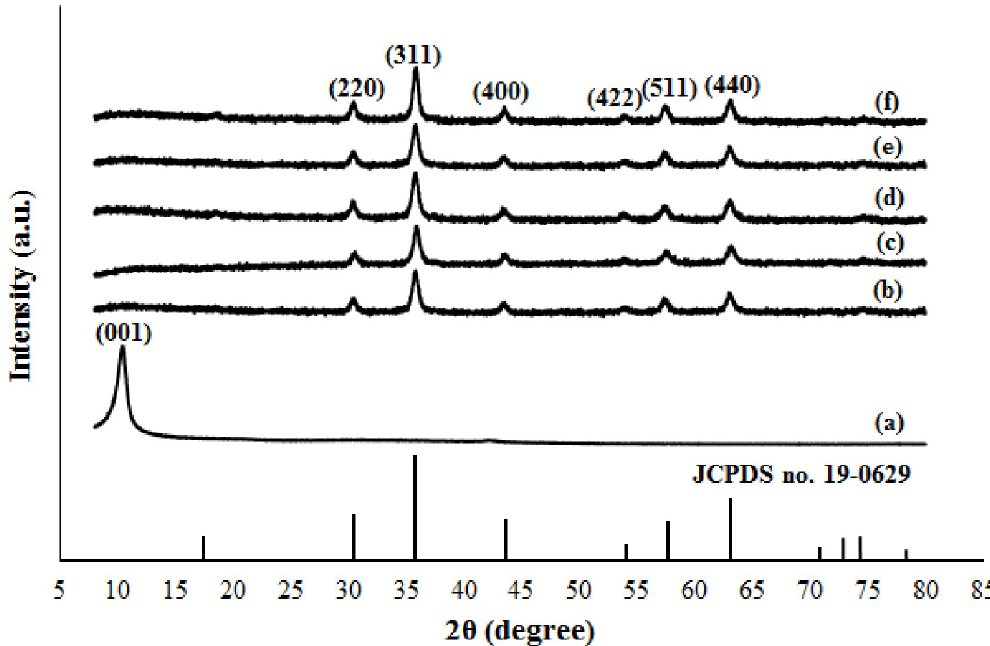
Fig 2. XRD patterns of (a) GO, (b) M-rGO3, (c) M-rGO6, (d) M-rGO12, (e) M-rGO18, (f) M-rGO24 and the reference data for